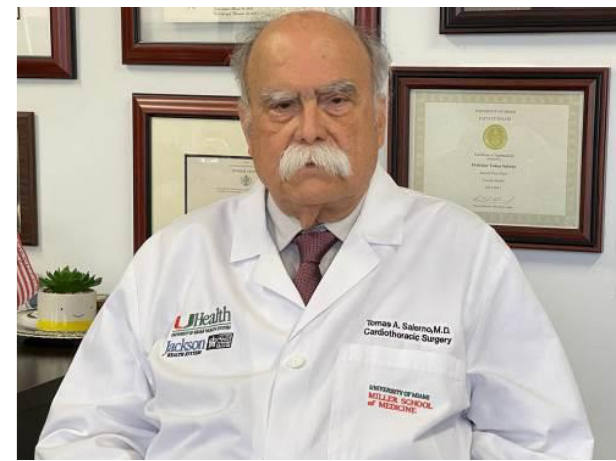
Fig. 10 - Dr. Tomas A. Salerno in his office at Jackson